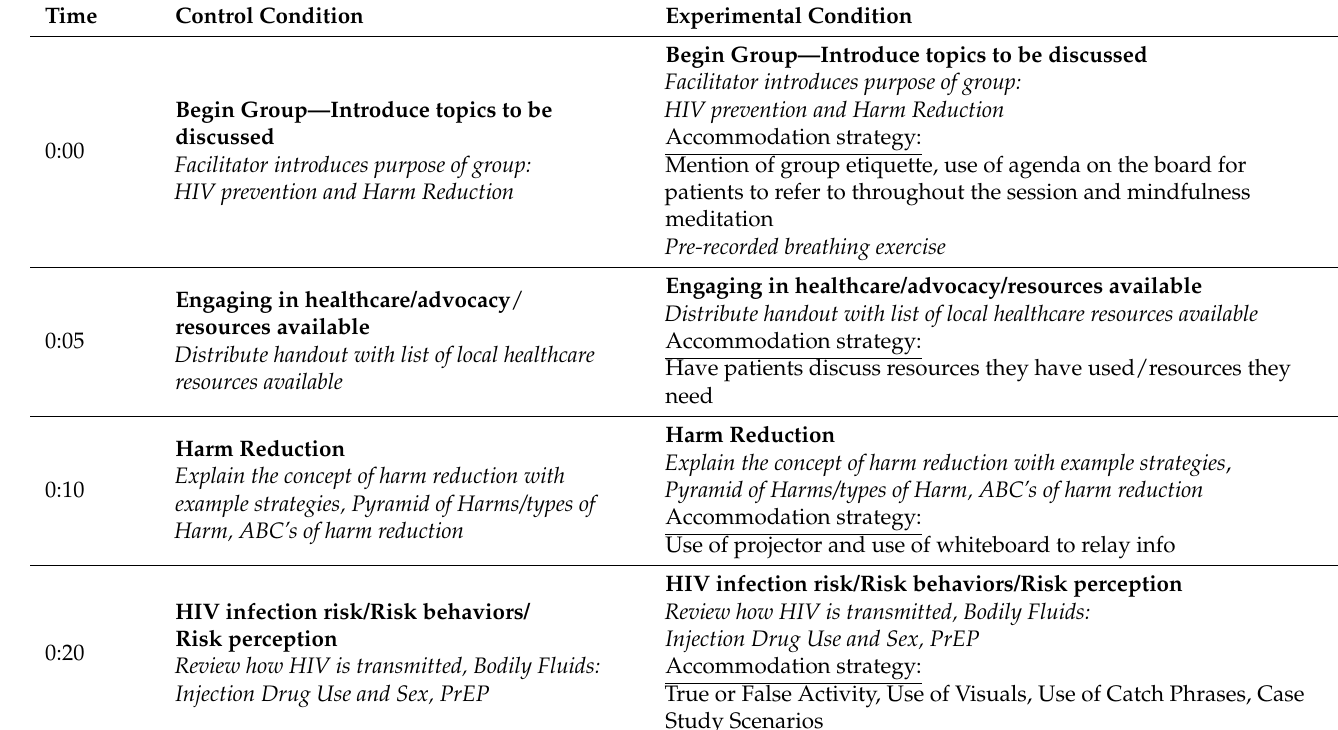
Table 1. Overview of control condition sessions and experimental condition